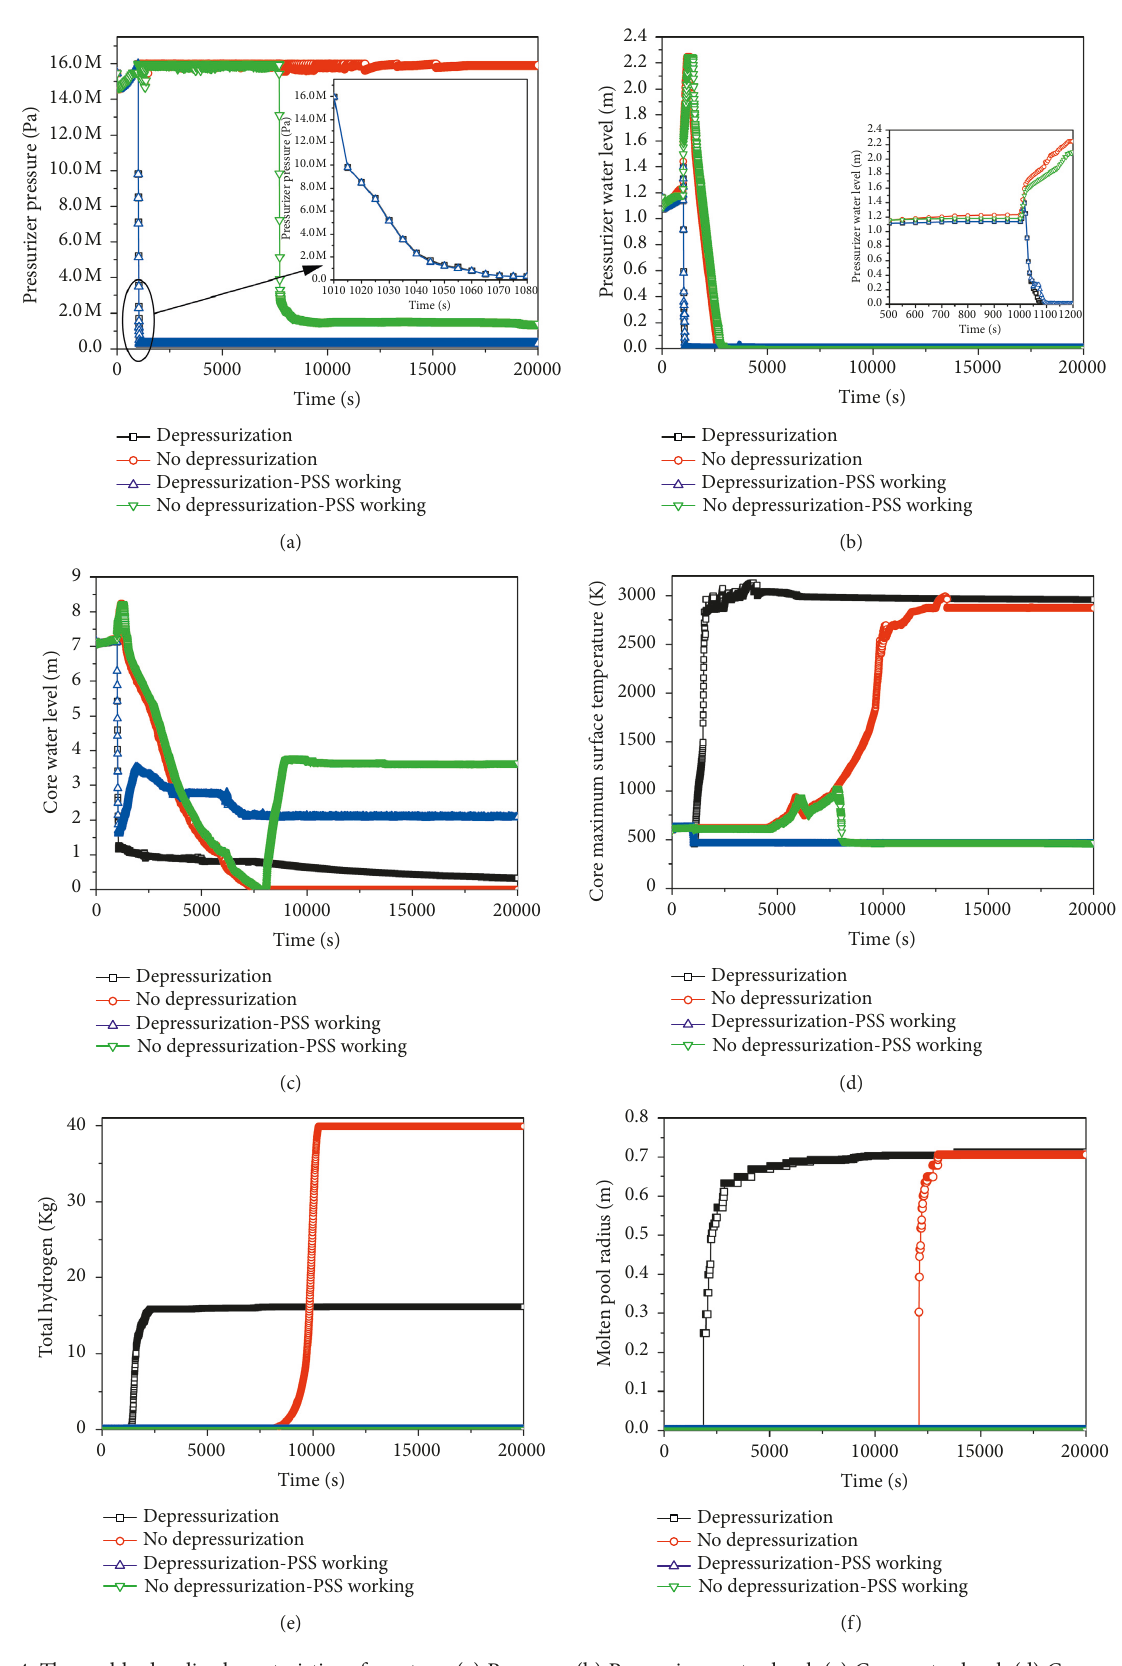
Figure 4: Thermal hydraulic characteristics of reactors. (a) Pressure. (b) Pressurizer water level. (c) Core water level. (d) Core maximum surface temperature. (e) Hydrogen total mass. (f) Molten